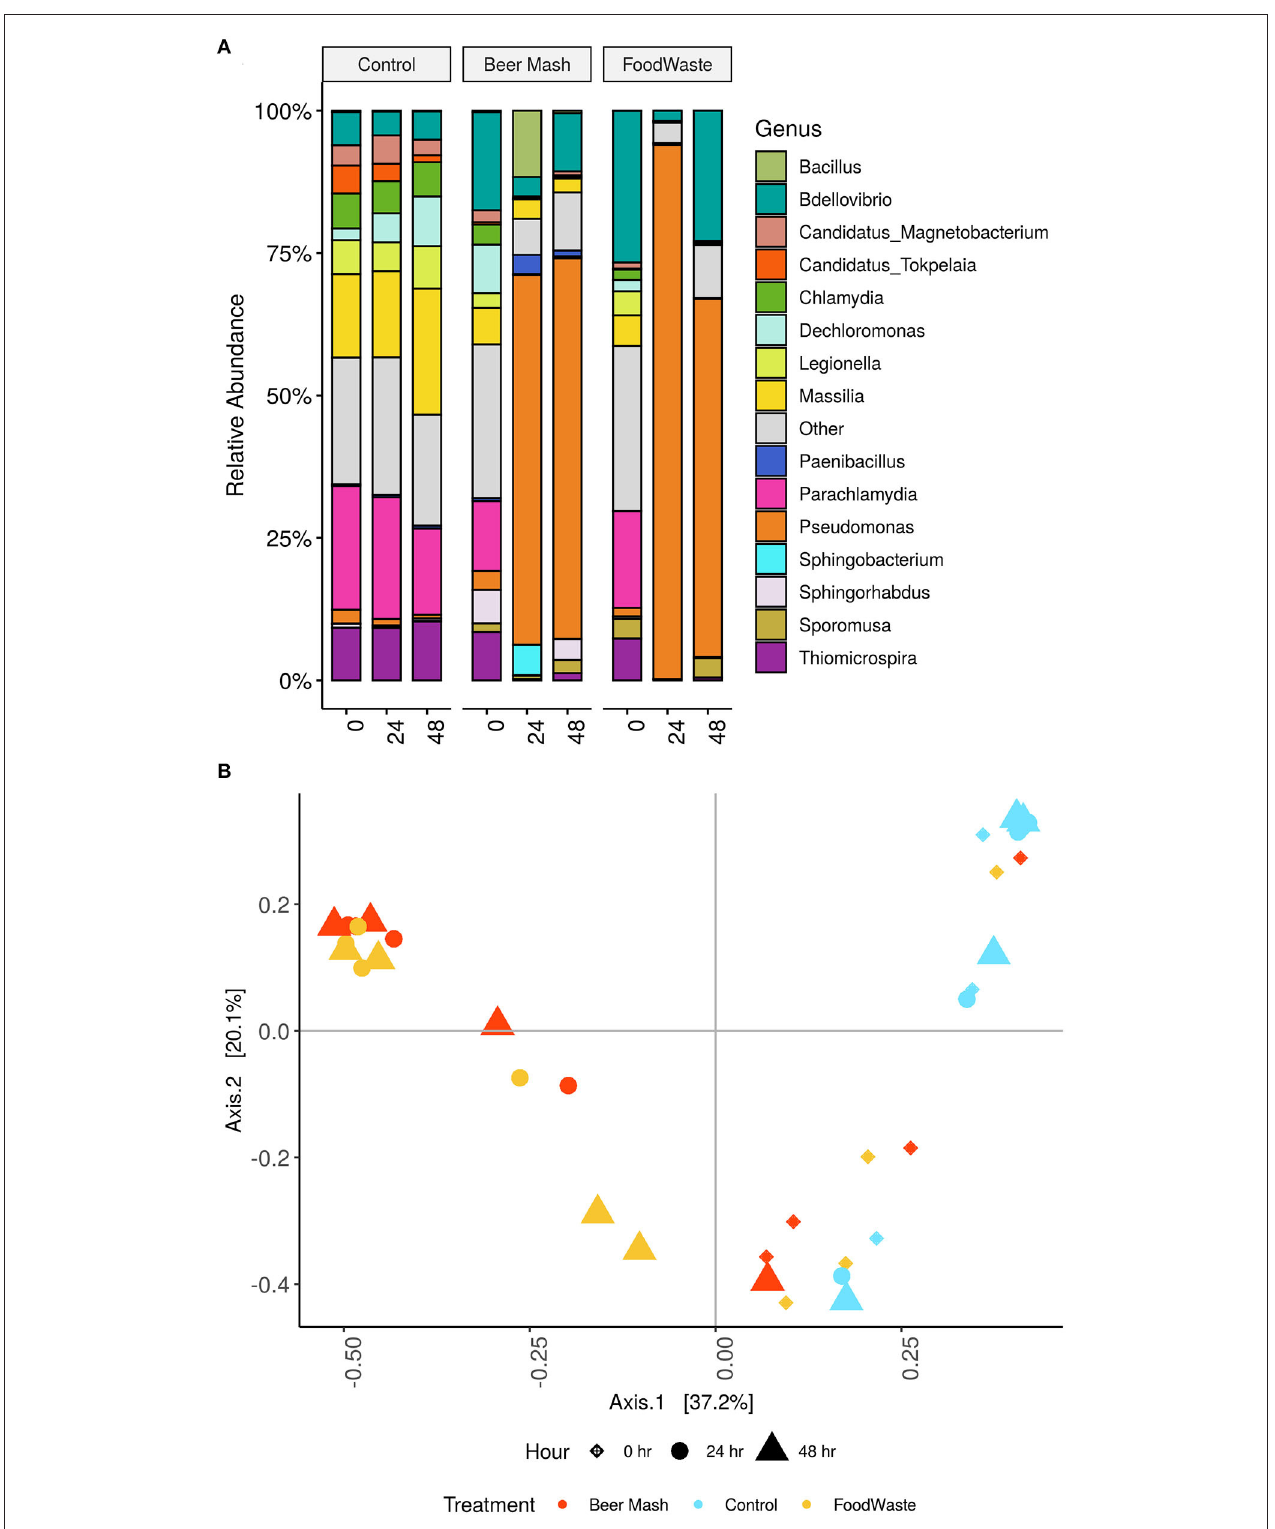
FIGURE 3 | (A) Stacked column bar graph representing the relative abundance and distribution of the 15 most abundant genera across the three nutrient solutions treated with FW and BM or not treated (control) and across time at 0, 24, and 48h. (B) Clustering of samples, following amendment of nutrient solution with FW and BM or not amended (control), by PCoA based on Bray-Curtis similarity distance. The first two principal coordinates are plotted on the x- and y-axes, respectively